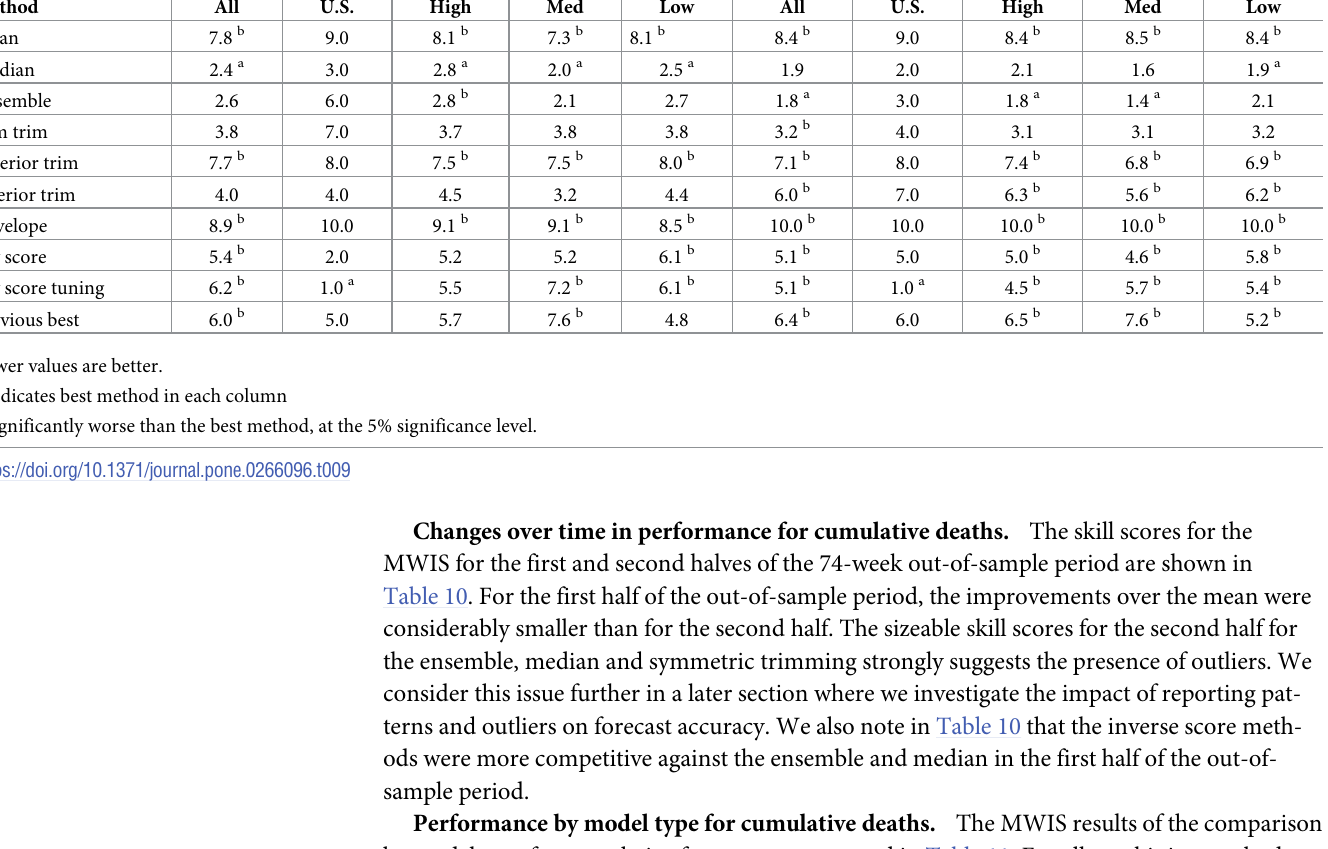
Table 9. For cumulative mortality, average ranks of the 95% interval MIS and MWIS. 95% interval MIS MWIS Method